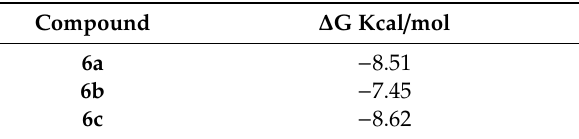
Table 3. ∆ G of binding of compounds 6a – c